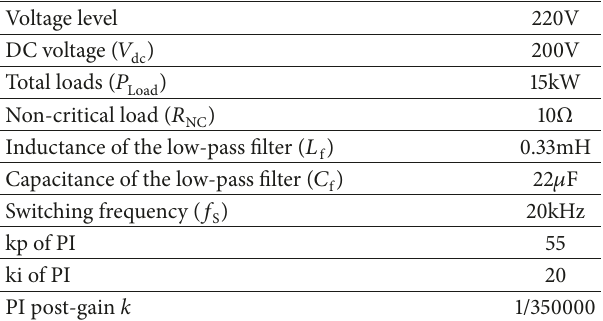
Figure 10: Demand side power waveform when ES is not activated. Table 1: Parameters of the simulation